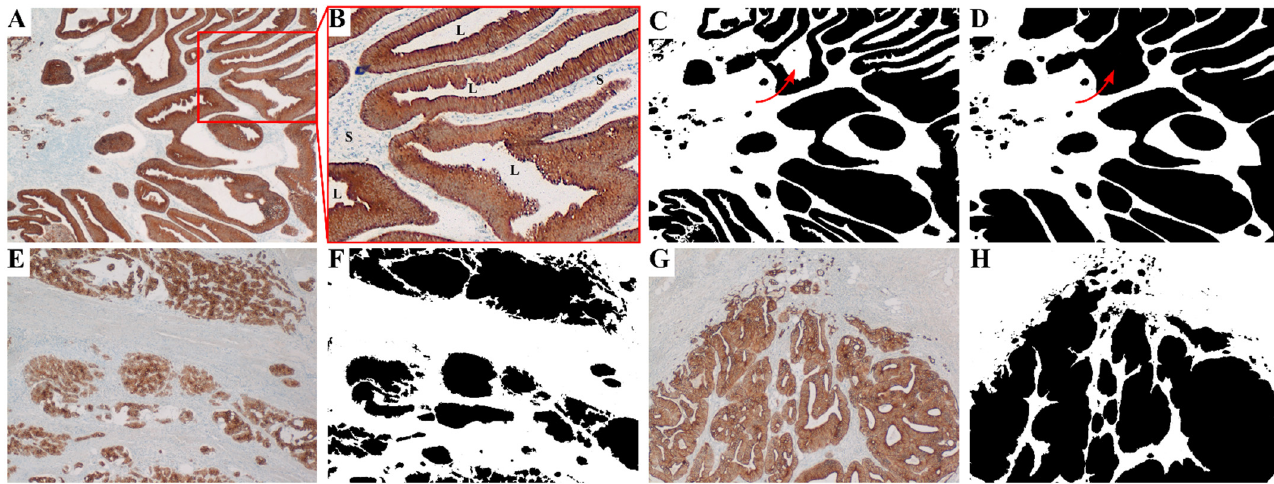
Figure 1. The image preparation process is illustrated in ( A – D ), starting with a stained image ( A ); then the intermediary ImageJ output ( C ); and the final image, which was manually corrected for lumen not filled by the algorithm ( D ). One such lumen is indicated with an arrow for better visibility. In ( B ), an enlarged section of ( A ) with enhanced contrast is shown to illustrate the difference between lumen, denoted by L, and stroma, denoted by S. Note that the cell nuclei in the stroma were stained blue, whereas the lumen remained white. Further shown are images of patients without metastasis ( E ), with metastasis ( G ), and the respective binary images fed to the network ( F , H ). The predicted risk of distant metastasis by BIgCoMet was 9.6% for F (low-risk group) and 85.5% for H (high-risk group).